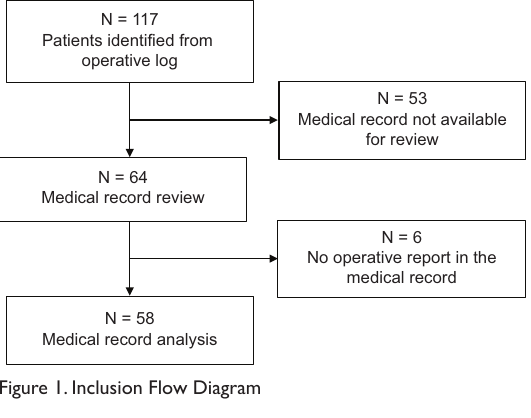
Figure 1. Inclusion Flow